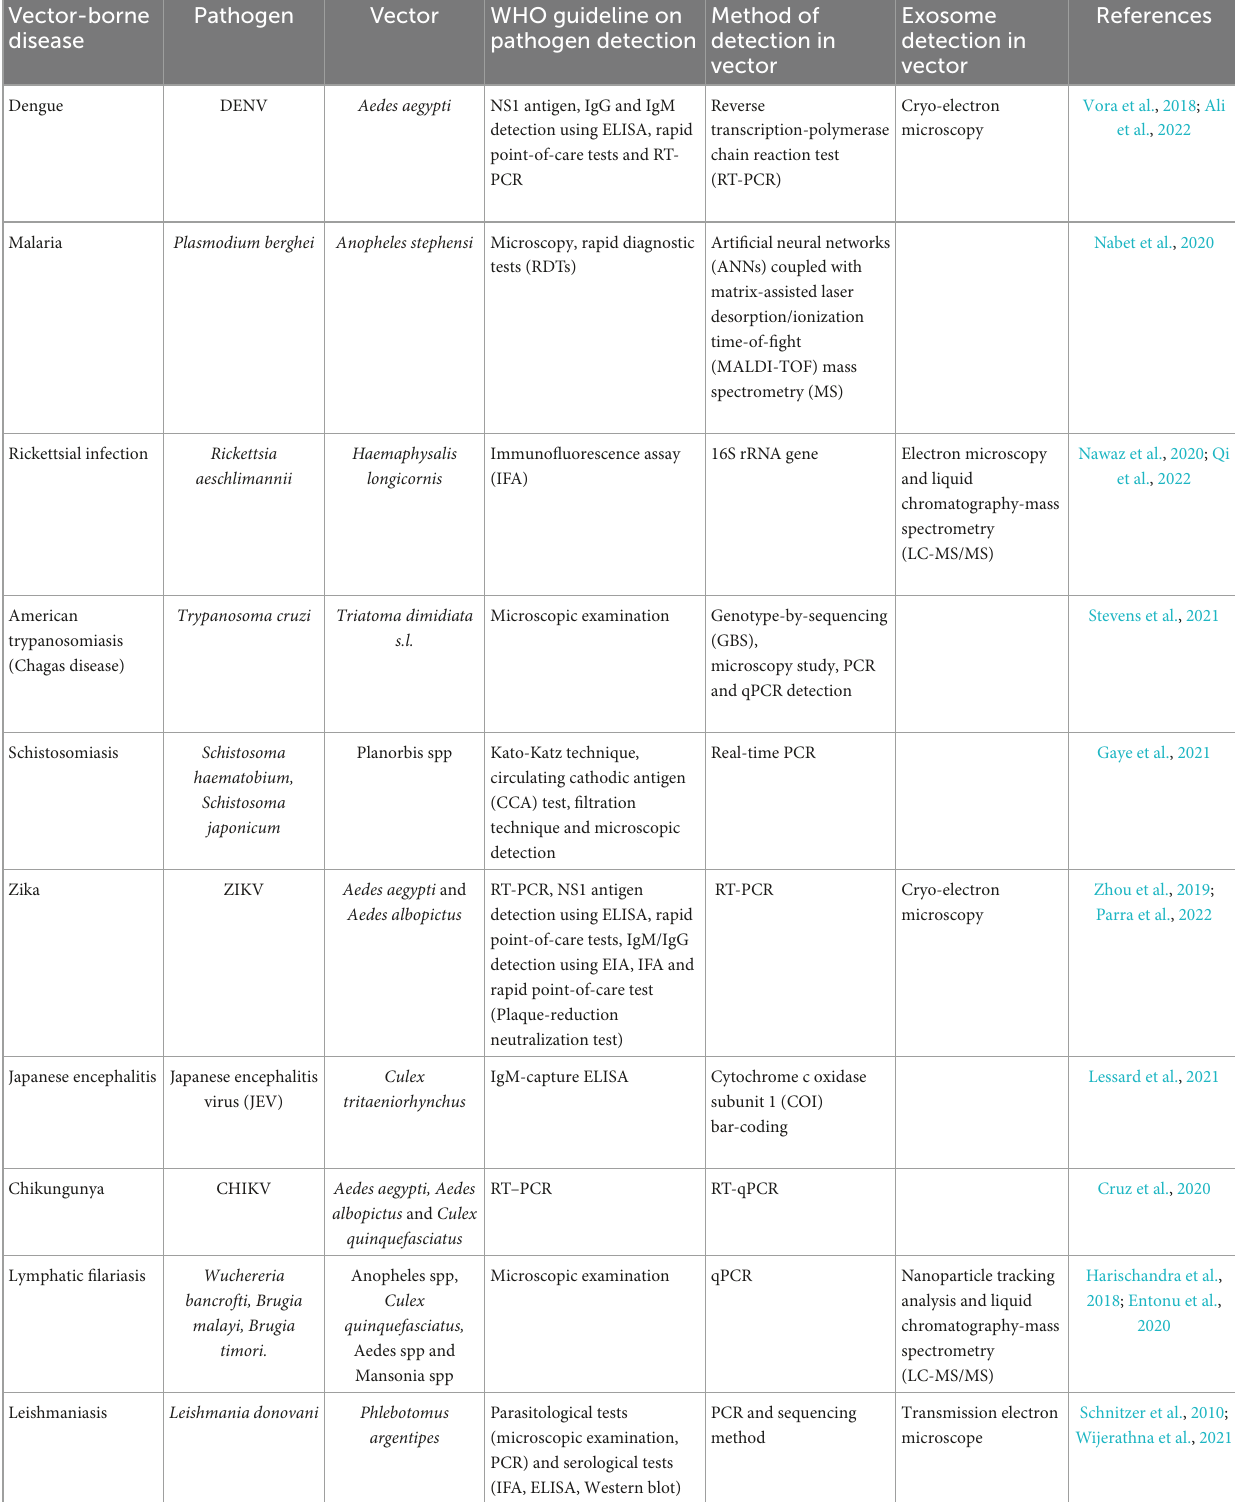
TABLE 2 Diagnostic methods for vector-borne disease detection in the host and their